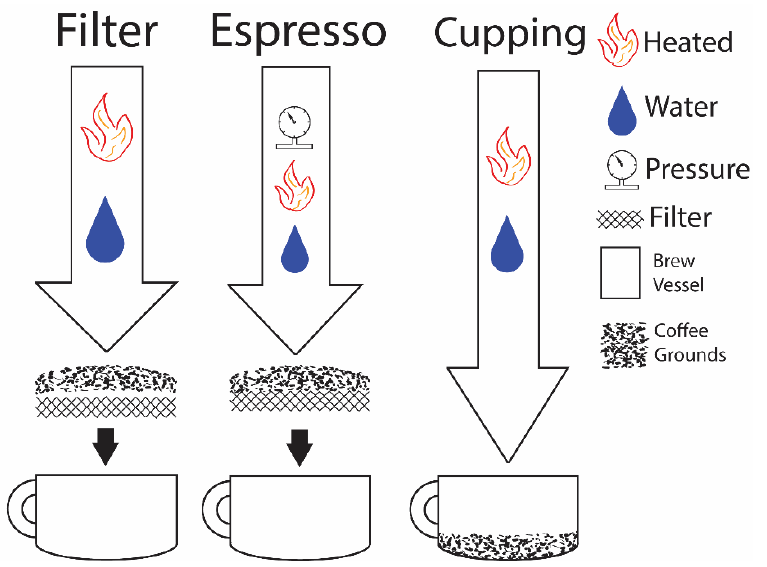
Figure 3. Common literature brew methods presented in a simplified format for easy method com- parison.